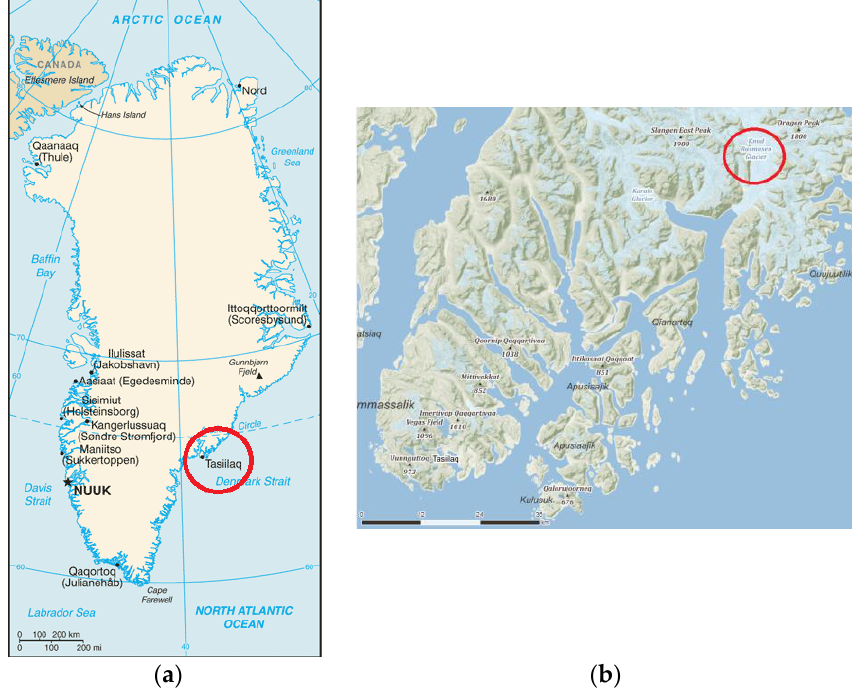
Figure 3. ( a ) Map of Greenland (http://www.getamap.net/maps/greenland_%5B_denmark_%5 D/ostgronland/_knud_rasmussen_glacier/) and ( b ) the Knud Rasmussen Glacier (66.0817028N, 36.3402919W),